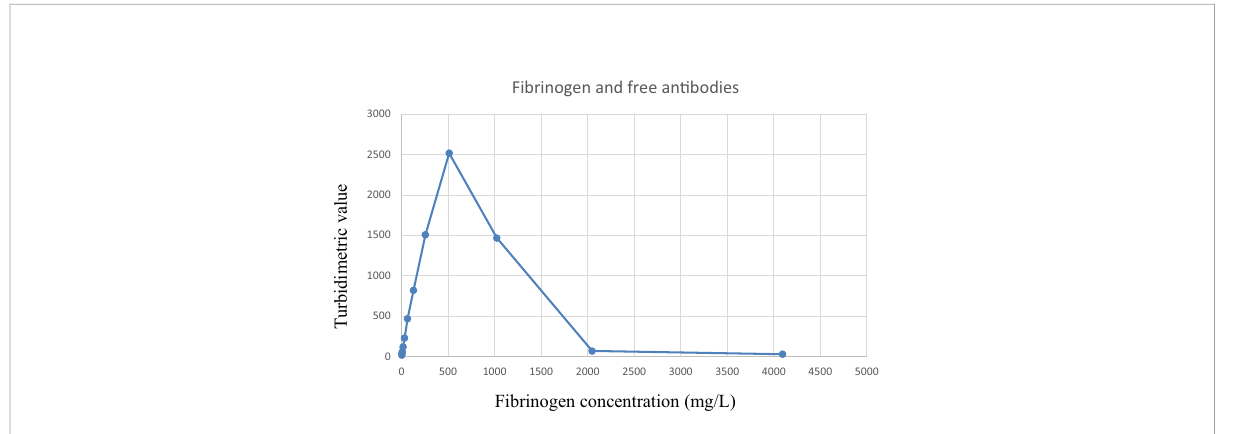
FIGURE 1 Reaction curve when using free avian anti- fi brinogen antibodies to detect fi brinogen in plasma samples. Observe the rapid decrease when the fi brinogen concentrations exceed the precipitation maximum (right hand side of the plot). The samples were analyzed as